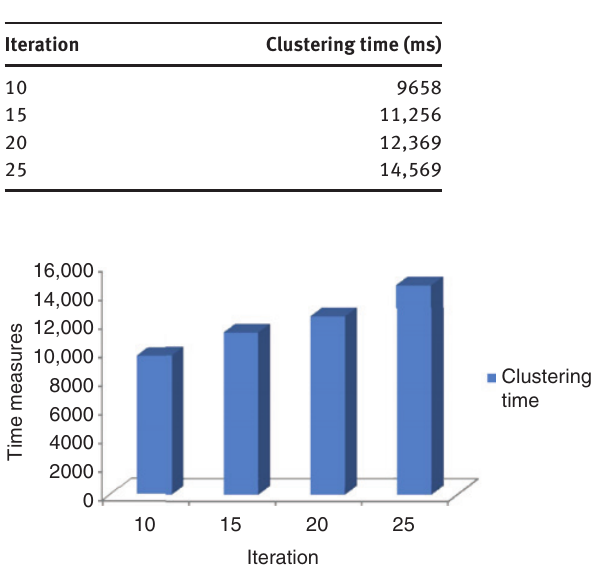
Figure 3: Graphical Representation of Clustering Time Measures for Our Proposed Research.